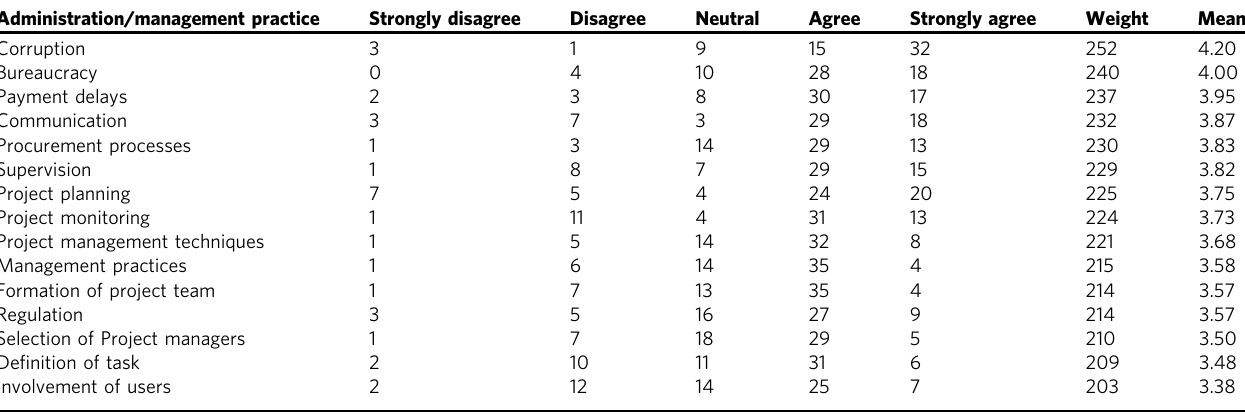
Table 4 Causes of public project failure from administration/management practices ( N = 60). Administration/management practice